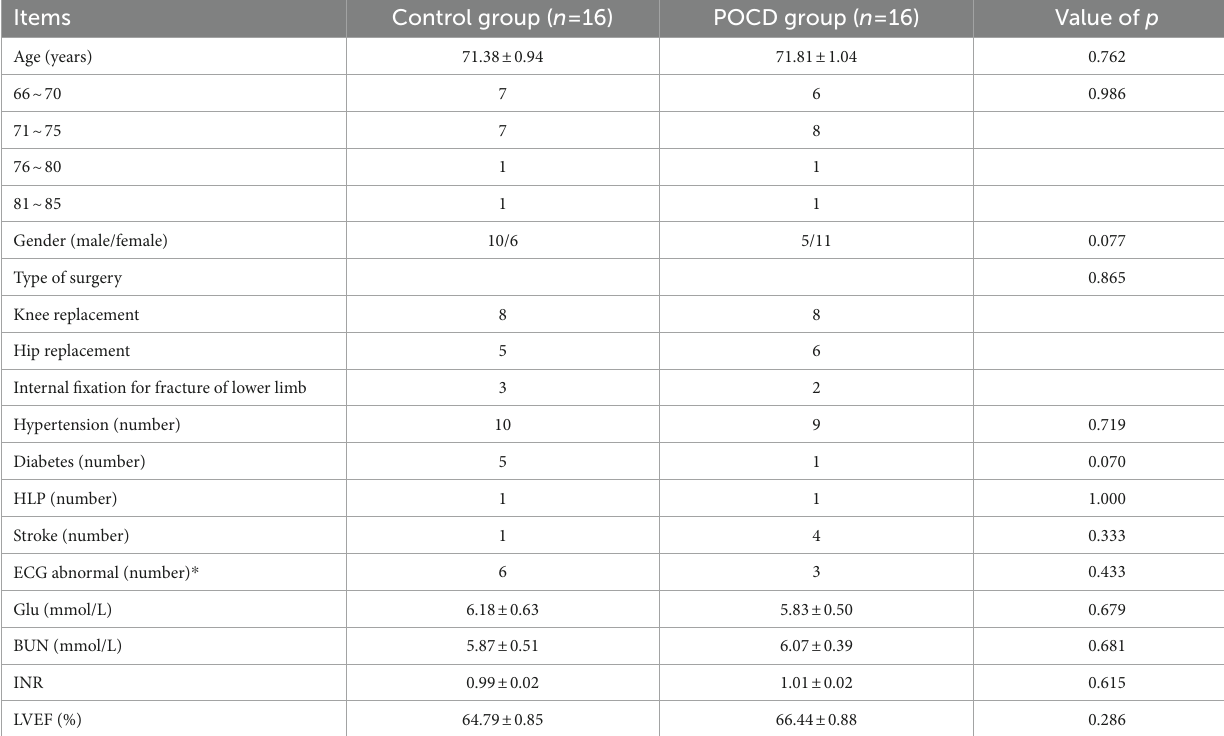
TABLE 1 General informations and medical history of the participants.